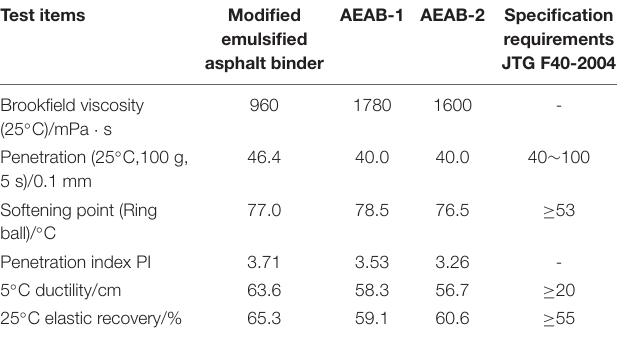
TABLE 6 | Basic properties of the materials.